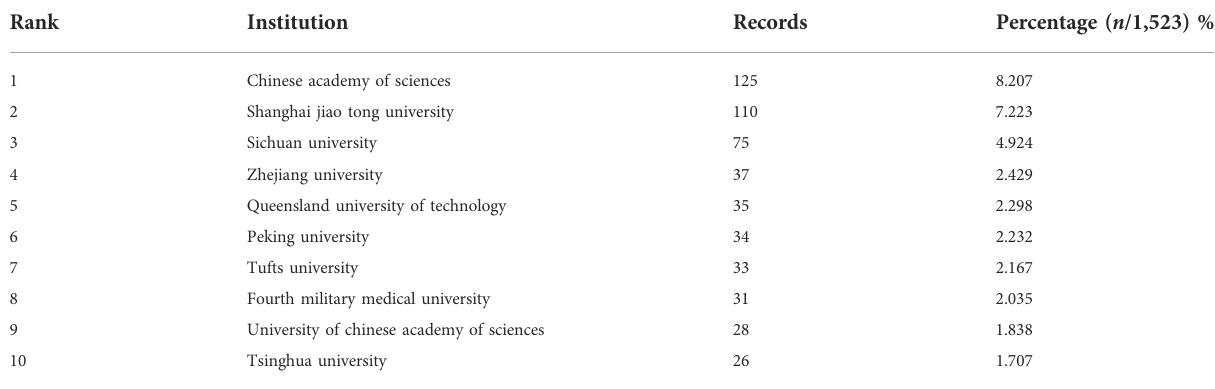
TABLE 2 The top 10 most productive institutions in biomaterials research in osteogenesis.